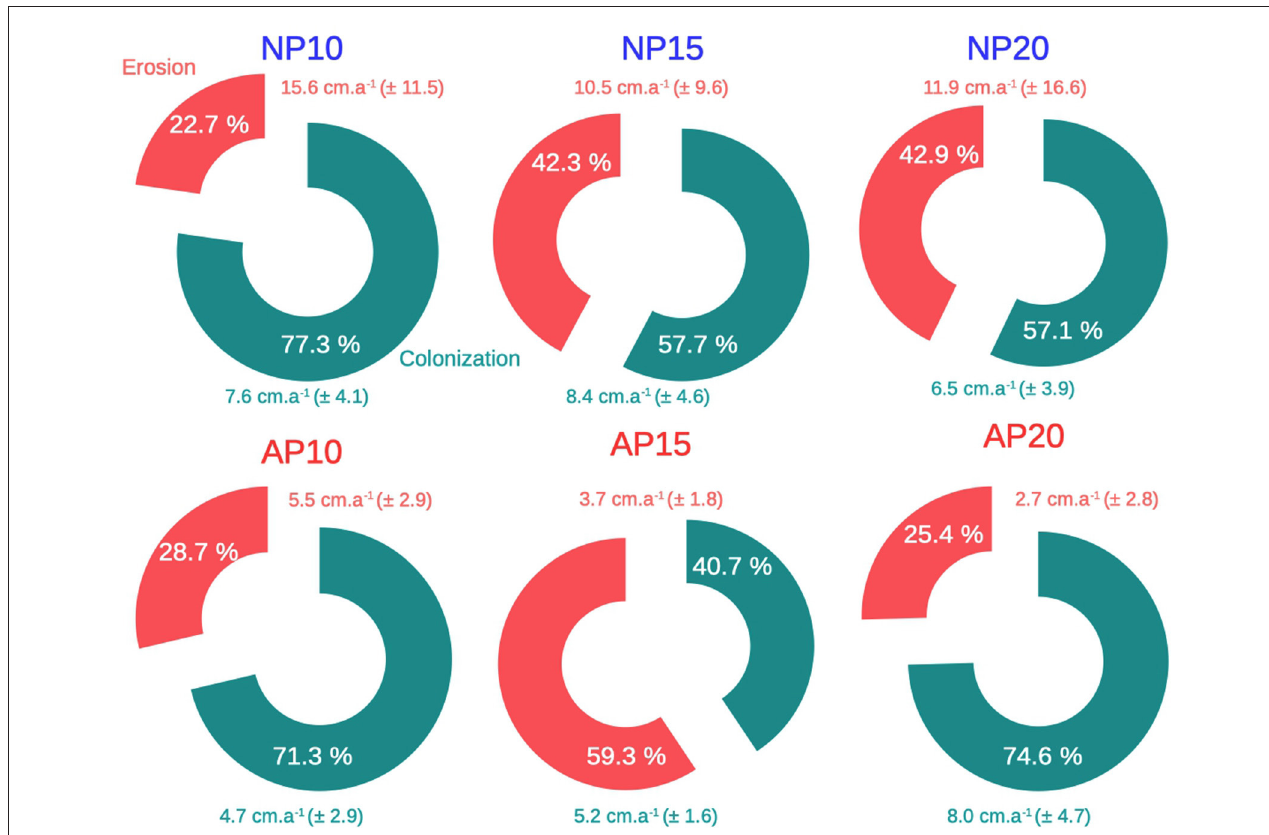
FIGURE 6 | Mean erosion (red) and colonization (green) in cm.a − 1 over the edge of natural (NP) and anchoring (AP) patches at 10, 15, and 20m depth between 2014 and 2016. Mean erosion and colonization speeds are expressed ± their standard deviation. Percentages represent the edge proportion of erosion and colonization over the whole patch